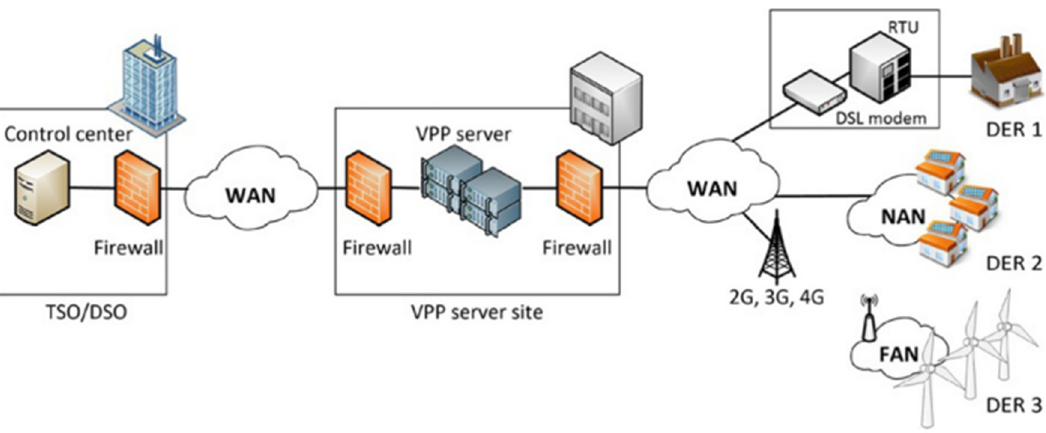
Figure 3. The architecture of VPPs communication system [21] .